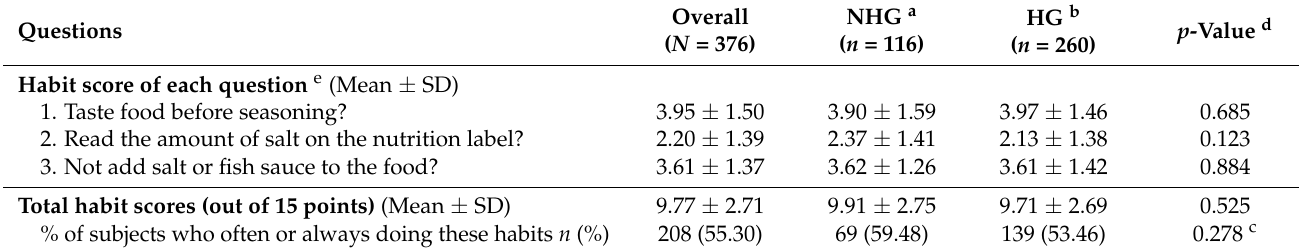
Table 6. Dietary-salt-related habits associated with